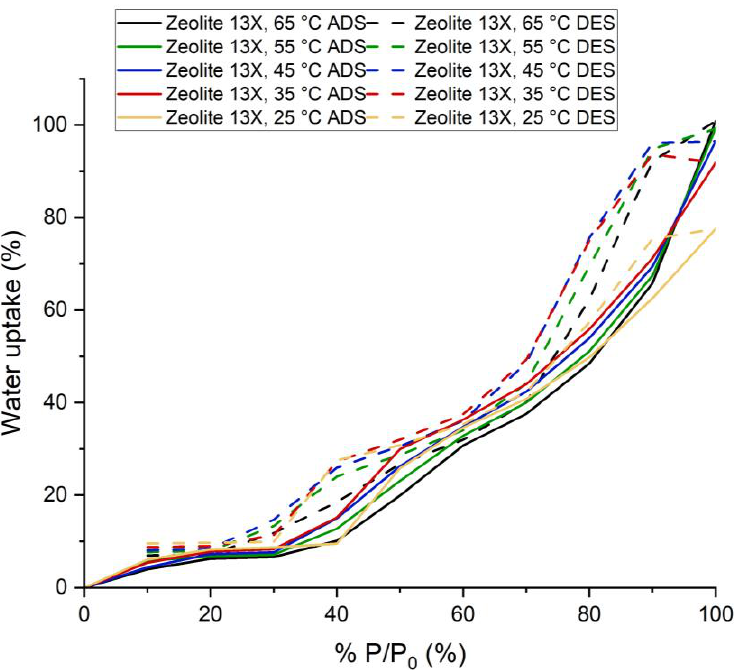
Figure 9. Adsorption and Desorption Isotherms for Synthesized 13X at five process temperatures: 25, 35, 45, 55 and 65 °C. 35, 45, 55 and 65 ◦